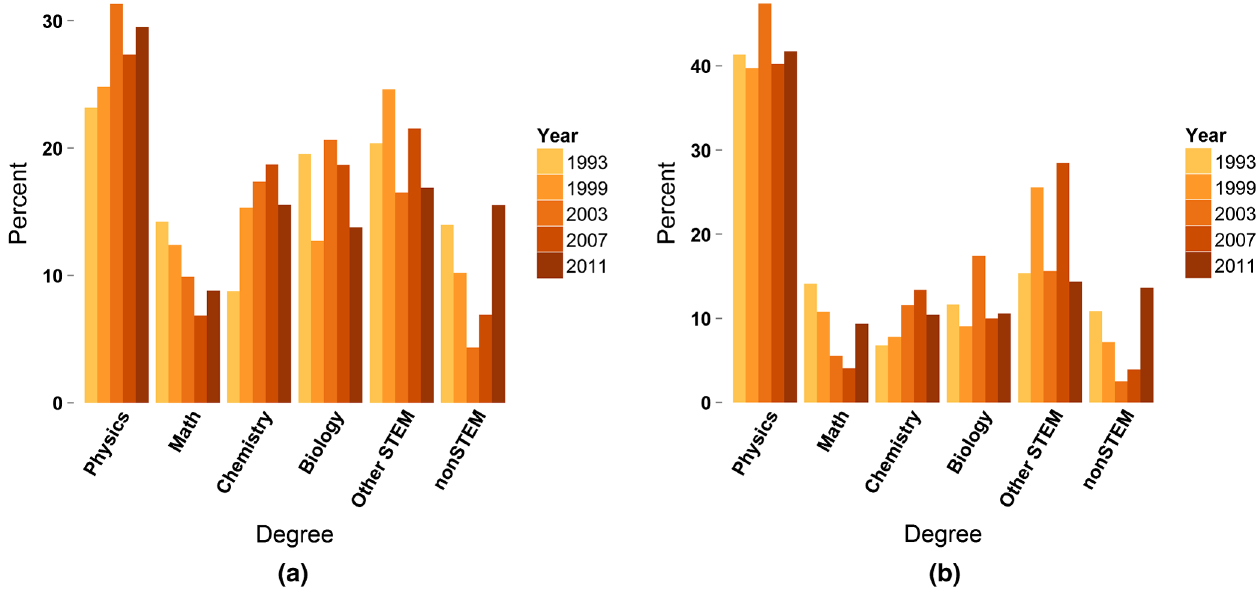
FIG. 2. Proportions of reported degree (or minor) of (a) physics teachers (standard error ≤ 4 . 48 %) and (b) teachers with a main assignment in physics (standard error ≤ 7 . 17 %) calculated for each survey year. Data is unavailable prior to 1993 due to a change in the